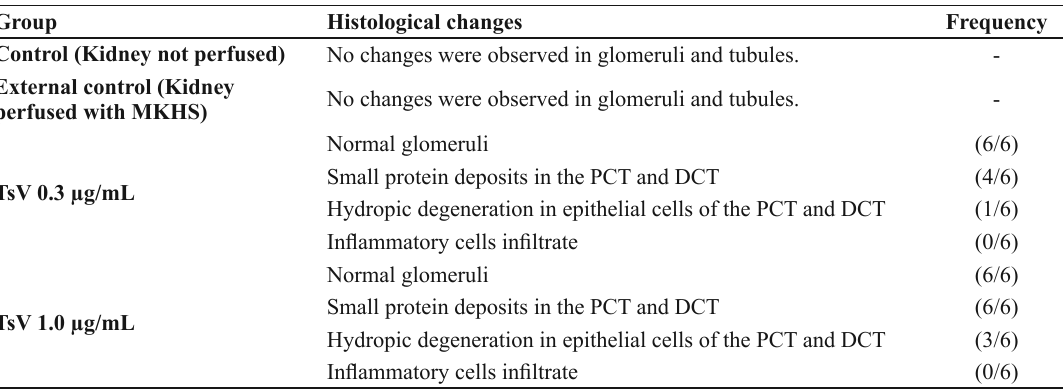
Qualitative histological analysis of the kidneys perfused with T. stigmurus venom (TsV) at 0.3 and 1.0 μ g/mL. Group Histological changes